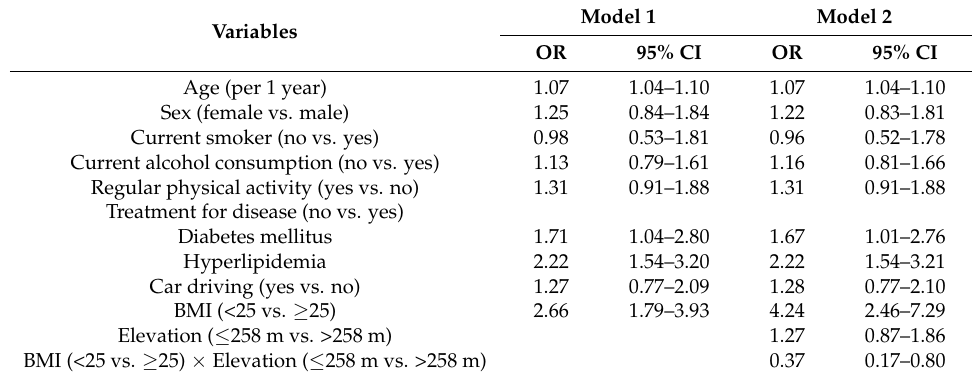
Multivariable logistic regression analysis with hypertension (Definition 1) as the dependent variable.